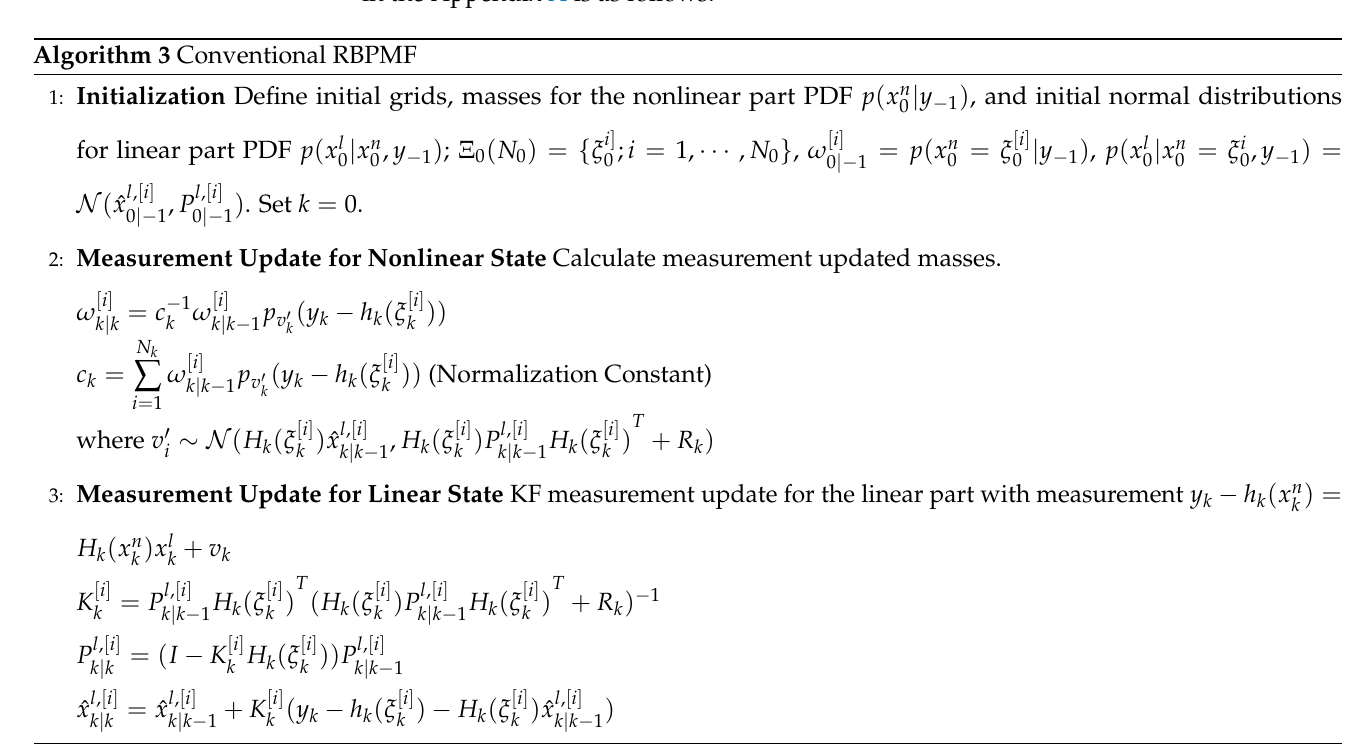
Figure 7. Illustrations of PMF and RBPMF concepts for two dimensional estimation problem ( a ) PMF ( b ) RBPMF. The conventional RBPMF algorithm based on the Bayesian framework summarized in the Appendix A is as